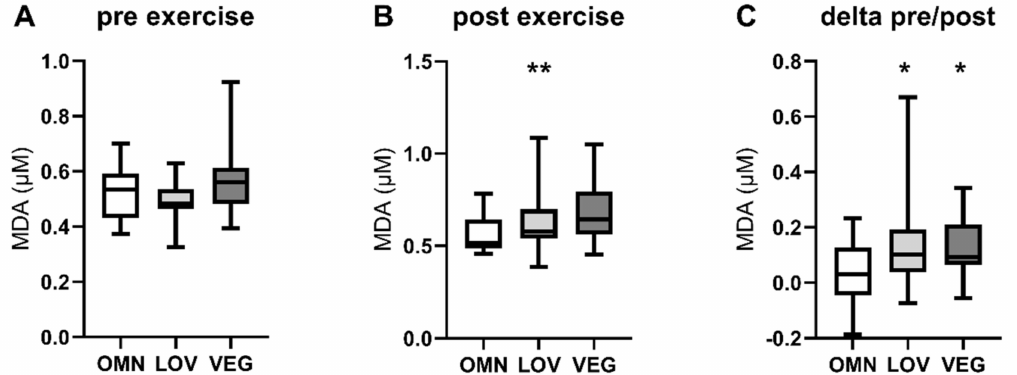
Figure 4. Levels of malondialdehyde (MDA) as a marker for oxidative stress pre, post, and pre / post exercise. The figure shows the levels of blood MDA before (pre) ( A ) and after (post) ( B ) exercise in the three analyzed study groups omnivores (OMN), lacto-ovo vegetarians (LOV), and vegans (VEG) ( B ). The change of MDA levels in blood calculated as pre / post di ff erence is also shown ( C ). Data are shown as median ± quartiles and extrema; n = 21–25; statistical analysis with Kruskal–Wallis test; * p < 0.05, ** p <